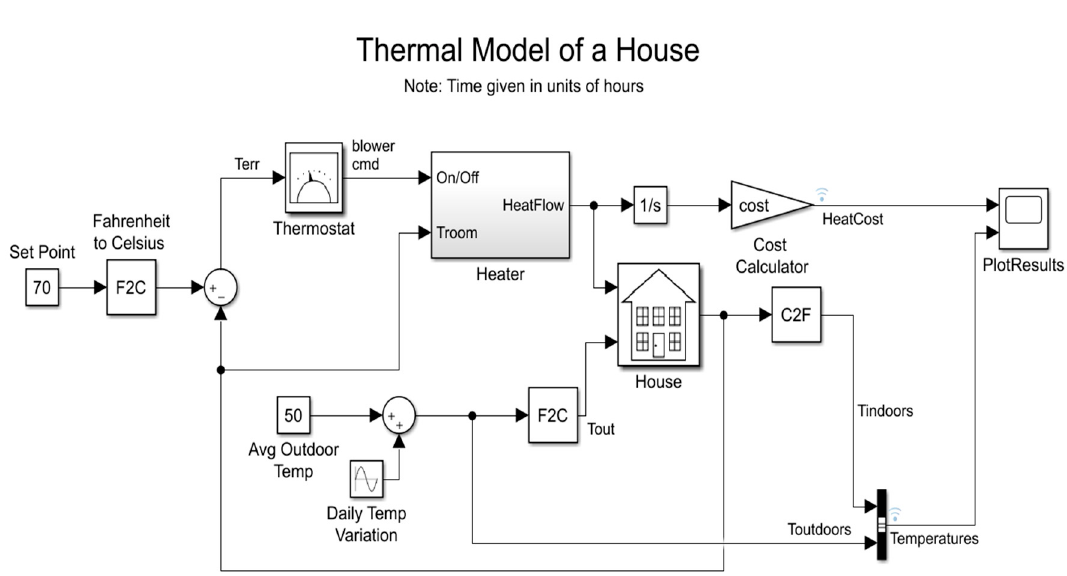
Figure 1. Thermal model of MATLAB simulink.